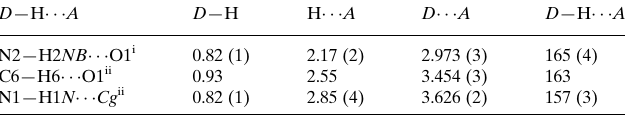
Hydrogen-bond geometry (A˚ , (cid:2) ). Cg is the centroid of the C1–C6